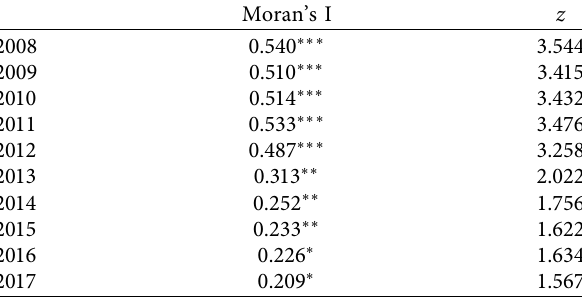
Table 5: Global Moran’s I Index of green innovation